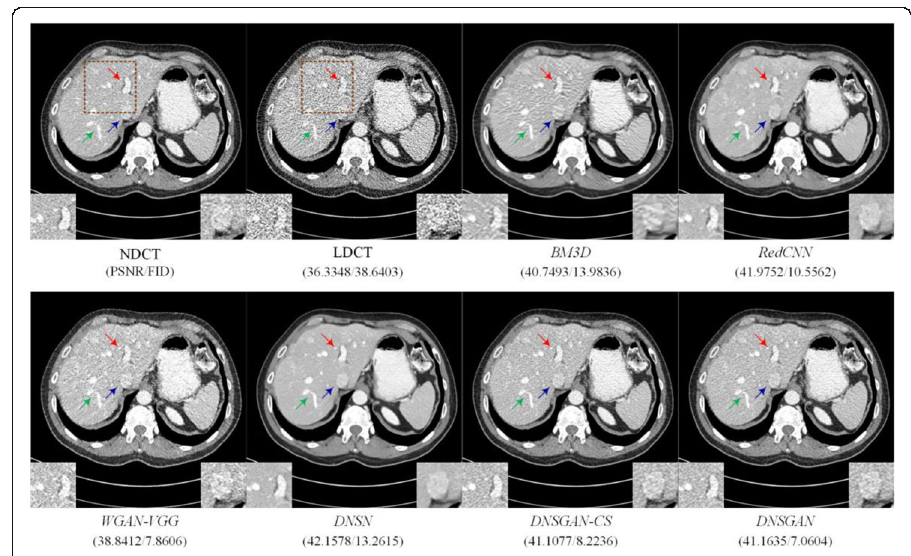
Fig. 5 Transverse CT image through the abdomen. The red and blue arrows denote zoomed ROI regions. The display window of this slice is [ − 180, 200] HU